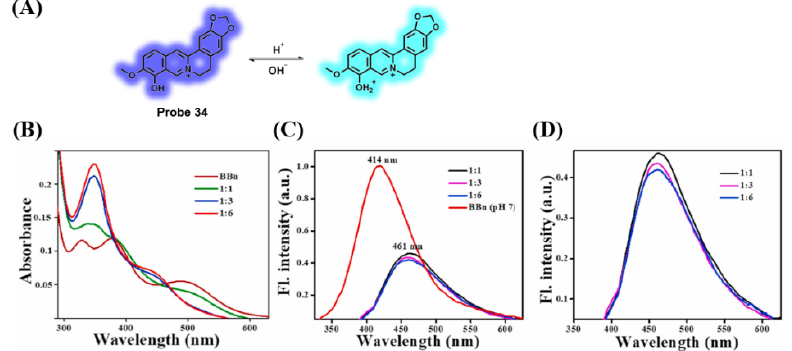
Figure 28. ( A ) Imaging mechanism of probe 33 ; ( B ) absorption spectra of probe 34 (20 μM) in PBS were measured for three different ratios of acetoacetate and 3-hydroxy butyric acid (i.e., 1:1, 1:3, and 1:6); ( C ) the fluorescence response of probe 33 in PBS was measured for three different ratios of acetoacetate and 3-hydroxy butyric acid (i.e., 1:1, 1:3, and 1:6); ( D ) expanded graph of ( C ). λ ex = 350 nm. Adapted from Reference [131]. Copyright 2021, Elsevier B.V.